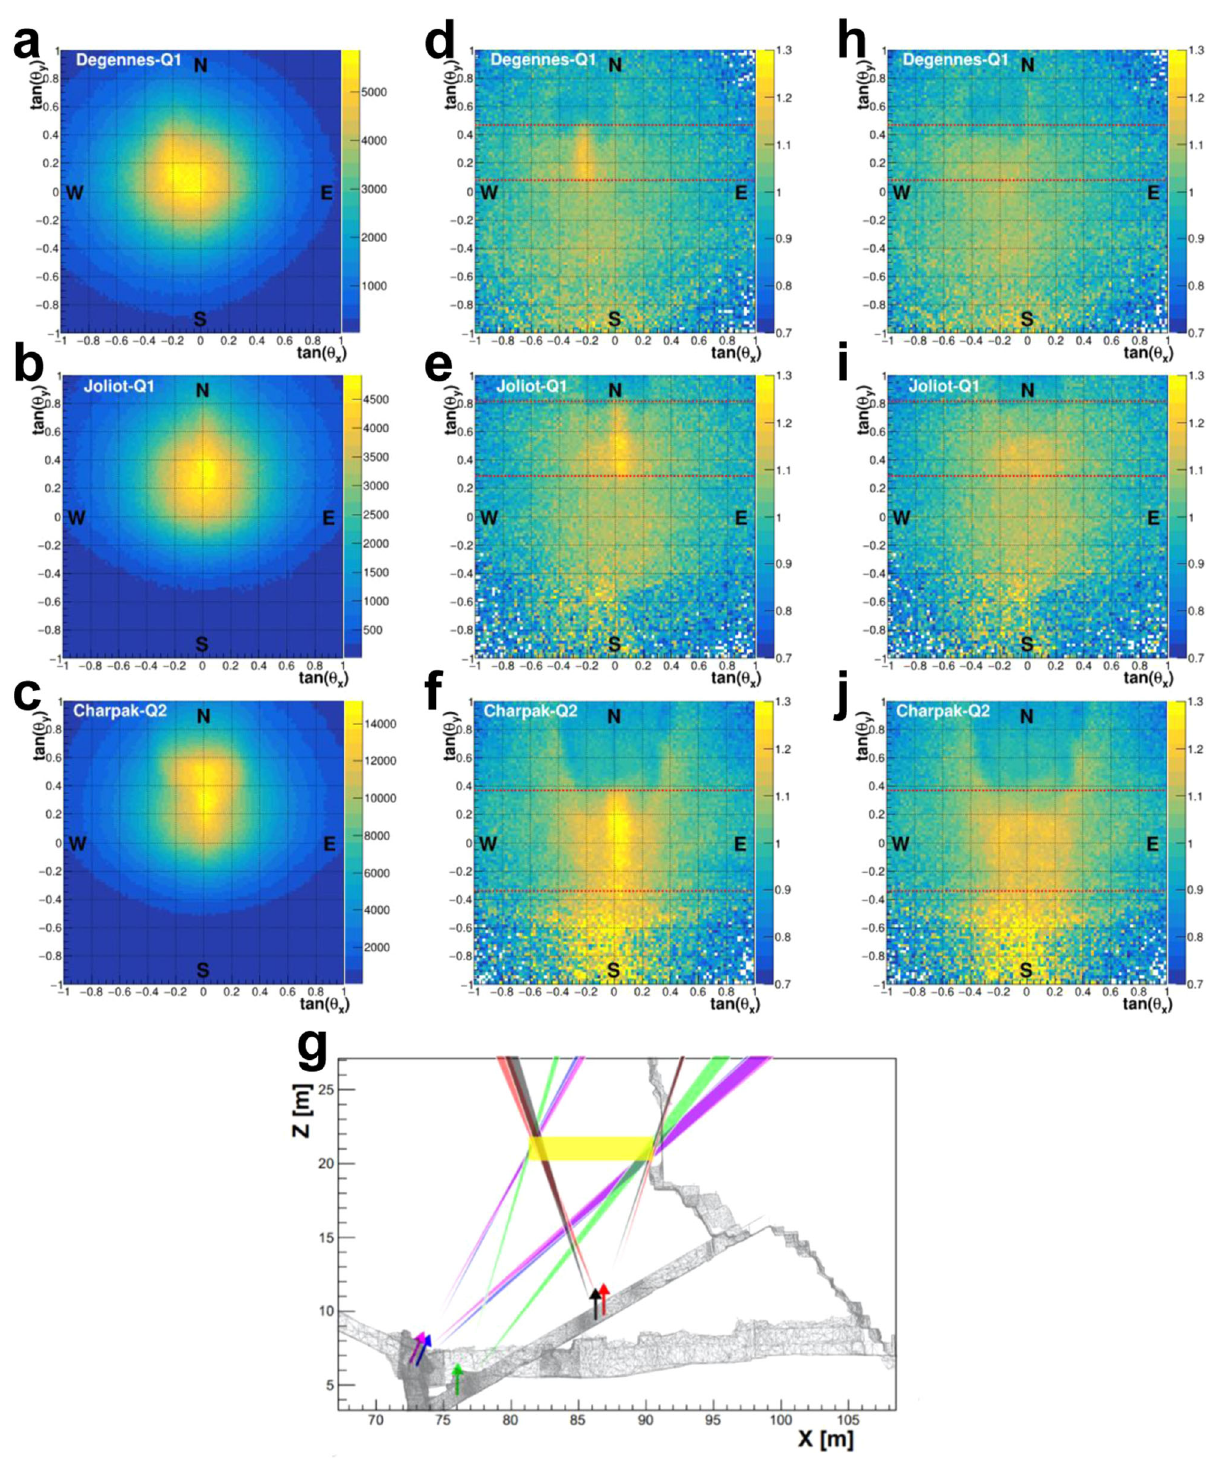
Fig. 7 | NFC signal and triangulation from CEA data. a – c Raw muographies obtainedwithDegennes-1,JoliotandCharpak-2. d – f Ratiobetweenthedataandthe simulation for these three instruments, showing good overall agreement except in the summit direction where the statistics is very low. The horizontal, dashed red linesindicatethelimitoftheNFCobtainedbyslicingeachimage. g Triangulationof the NFC using the fi ve instruments, where each cone represents the extremity of the NFC found in one data set (i.e., the directions de fi ned by the red lines in plots